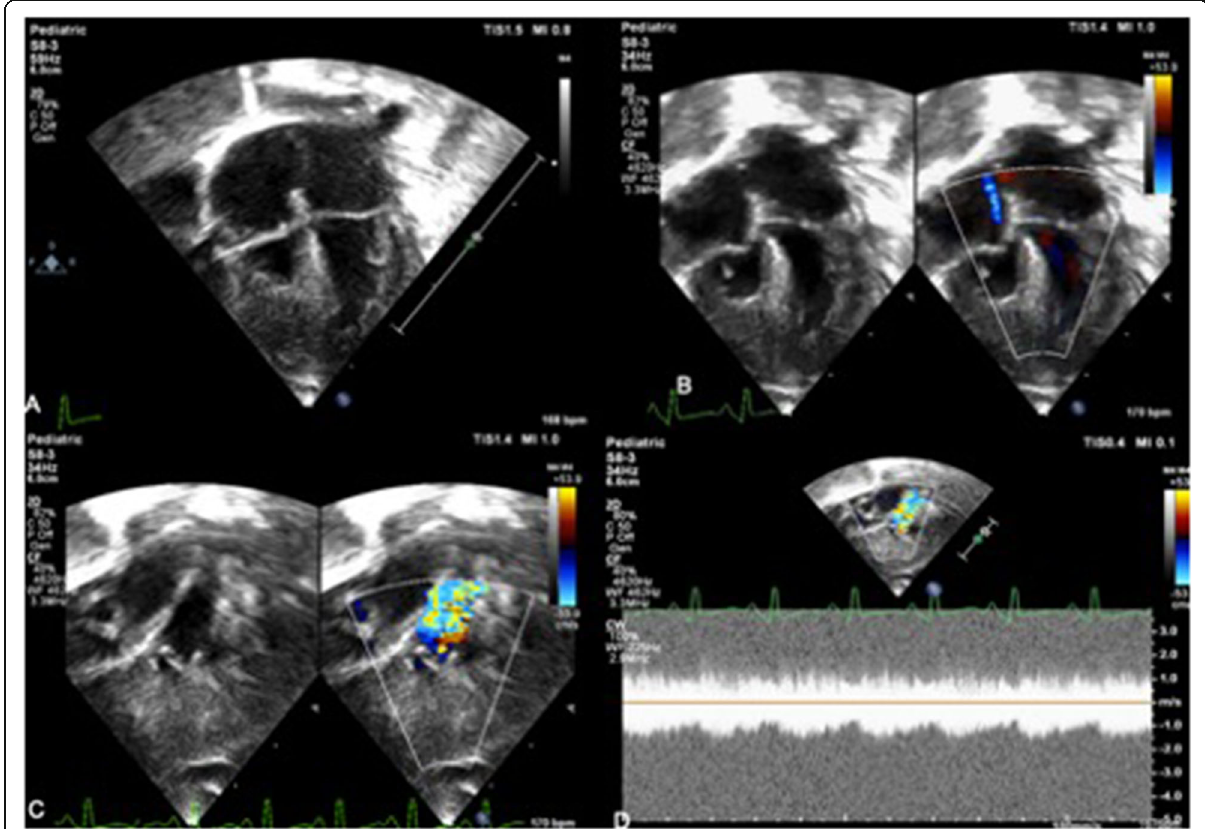
Fig. 1 Echocardiogram showing hypoplastic and hypertrophied right ventricle with TV Z score-1.95. b Color doppler showing tricuspid regurgitation jet (RVSP 110 + mean RAP). b , c PDA seen filling the MPA. d CW showing the continuous flow across MPA due to its filling from